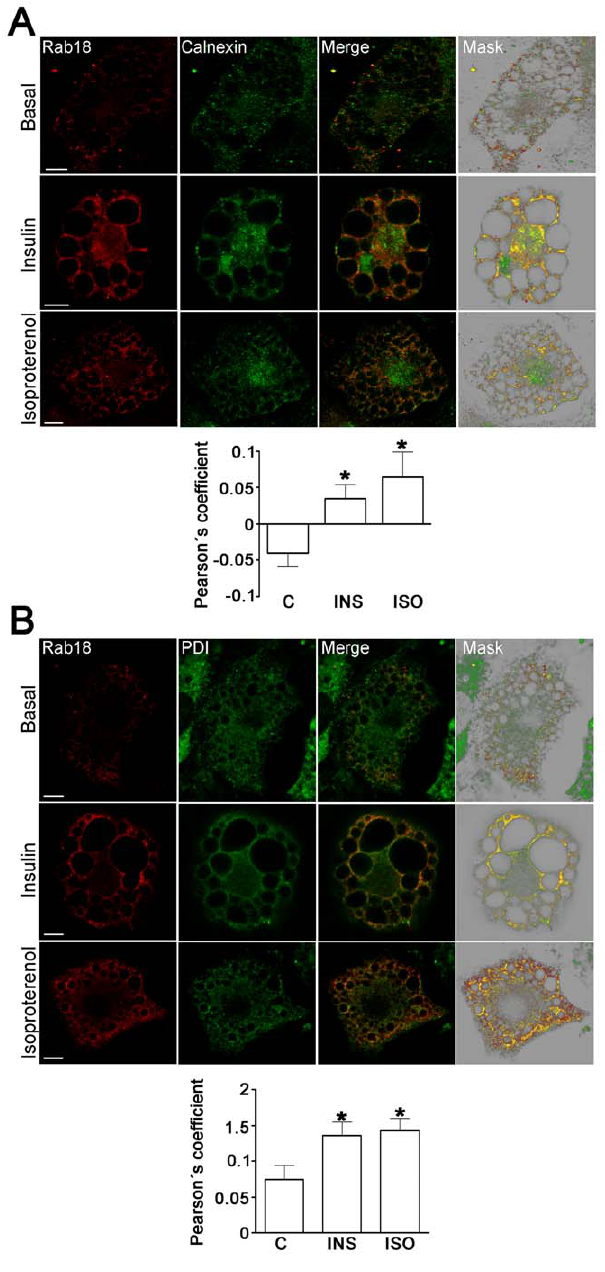
Figure 5. Effects of insulin and isoproterenol on Rab18 localization in relation to the ER. Representative confocal images of 3T3-L1 adipocytes under basal conditions or treated with 100 nM insulin or 10 m M isoproterenol for 4 h. After treatment, cells were co- immunostained for Rab18 (red) and the ER markers calnexin (A) or protein disulfure isomerase (B). In all cases, regions of interest containing a group of Rab18-positive LDs are presented. The colocalization channel was isolated using Imaris 6.4 (Bitplane) and shown alone in theimages on the far right. Scale bars, 2 m m. To quantify the degree of colocalization, Pearson’ coefficients were calculated for each experimental condition and represented as the mean 6 SEM of, at least, 10 cells per experimental group. *, P , 0.05 vs. untreated